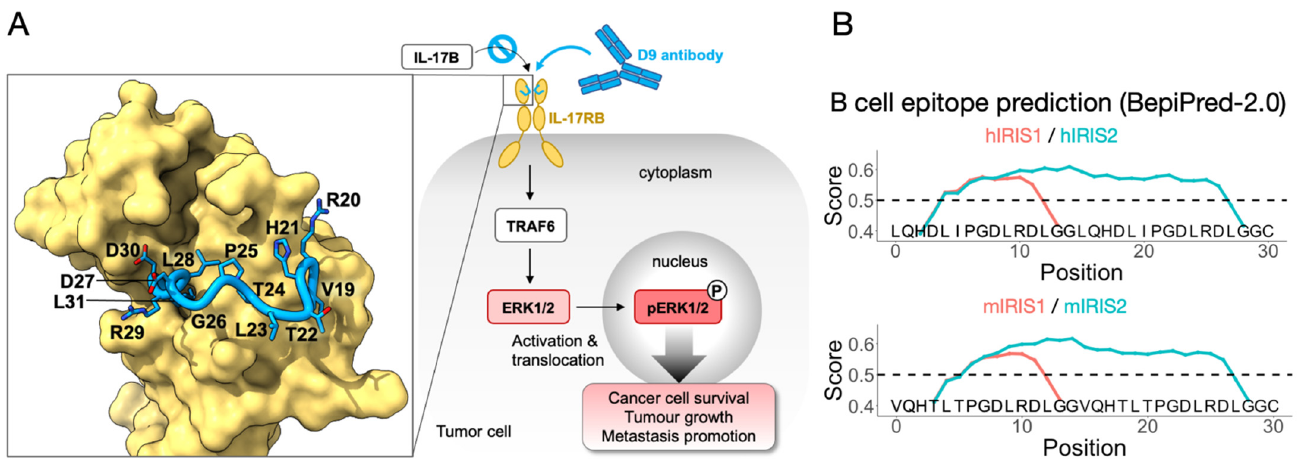
Figure 1. Schematic view of IRIS identification and B-cell epitope prediction. ( A ) Briefly, the D9 monoclonal antibody binding to IL-17RB abrogates IL-17B/IL-17RB downstream signaling and reverts tumor malignancy. Using X-ray crystallography, we previously determined the IL-17RB epitope recognized by D9, namely IRIS, which is shown as a blue loop with side chains in sticks, the rest of the IL-17RB structure is on the yellow surface. ( B ) IRIS1/2 designs using either a human (upper panel) or mouse (lower panel) sequence are subjected to B-cell epitope prediction (BepiPred2.0). The prediction score was set to default (0.5), which is indicated by horizontal dash line. Table 1. IL-17RB inactivation site (IRIS) homologue sequence and synthesized peptide design.